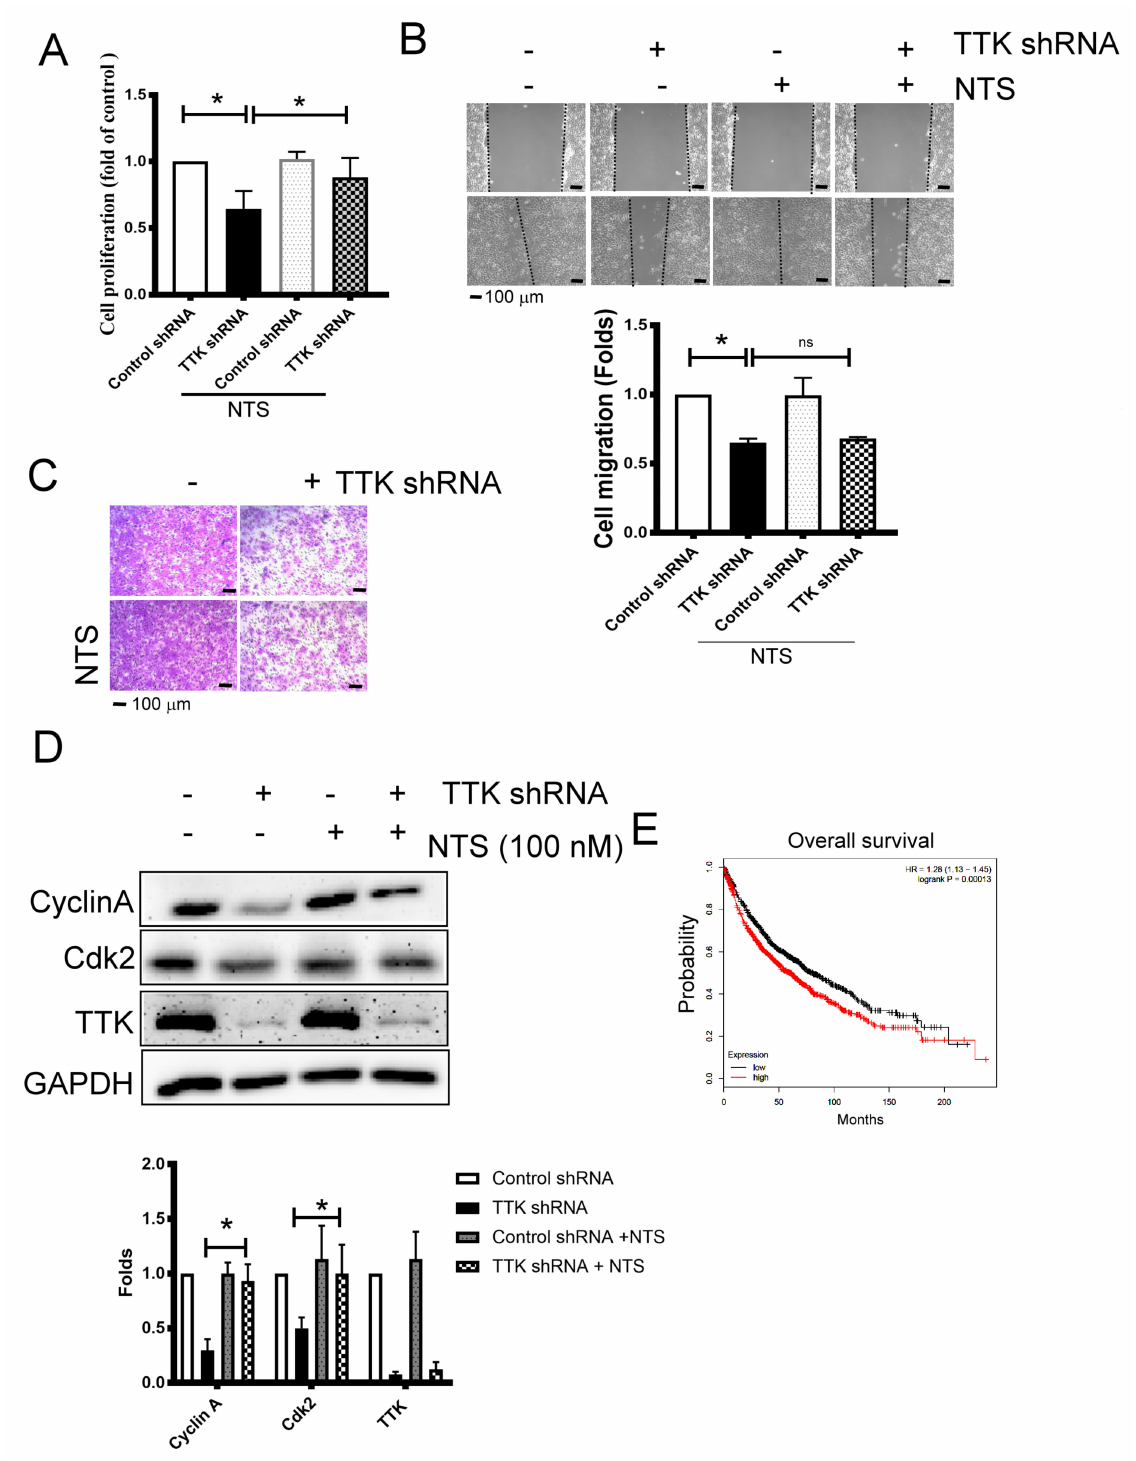
Figure 5. NTS contributes TTK-mediated cell proliferation. ( A ) NTS reversed cell proliferation inhibition ( A ), but not cell migration, as determined by wound healing ( B ) and the transwell system ( C ) by TTK knockdown. The cell proliferation of A549 or TTK knockdown A549 cells was determined by WST-1 after 72 h incubation. Control shRNA or TTK shRNA plasmid transfected A549 were seeded in the upper insert in serum-free medium with or without NTS. The complete culture medium was added into the lower well to act as a chemo-attractant for 24 h. The migratory cells were quantified by crystal violet staining. ( D ) NTS prevented the decrease of cyclin A and cdk2 regulated by TTK inhibition.